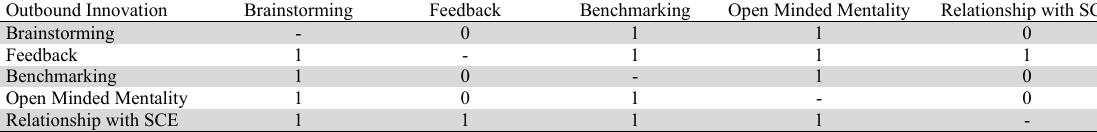
Concordance matrix for the criterion outbound innovation Outbound Innovation